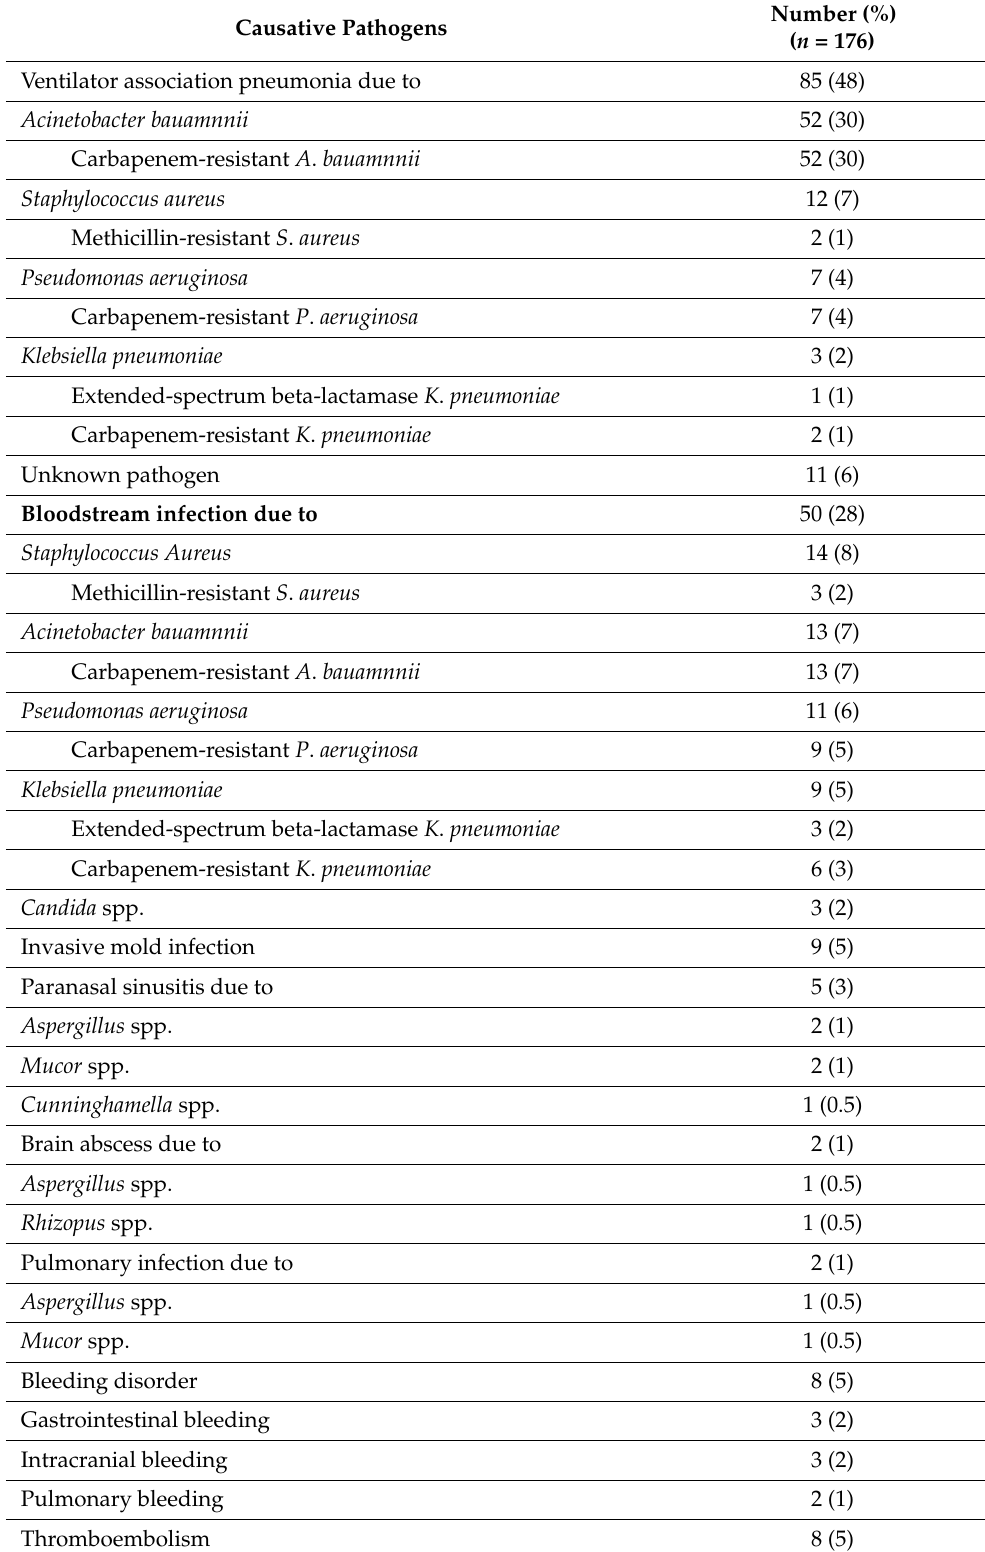
Table 5. Causes of in-hospital deaths in patients with community-acquired pneumonia (CAP) due to coronavirus disease 2019